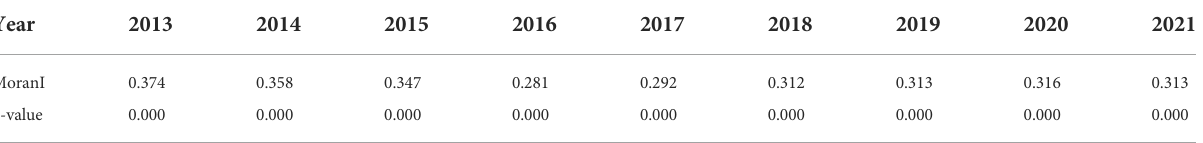
TABLE 2 MoranI auto correlation test results.